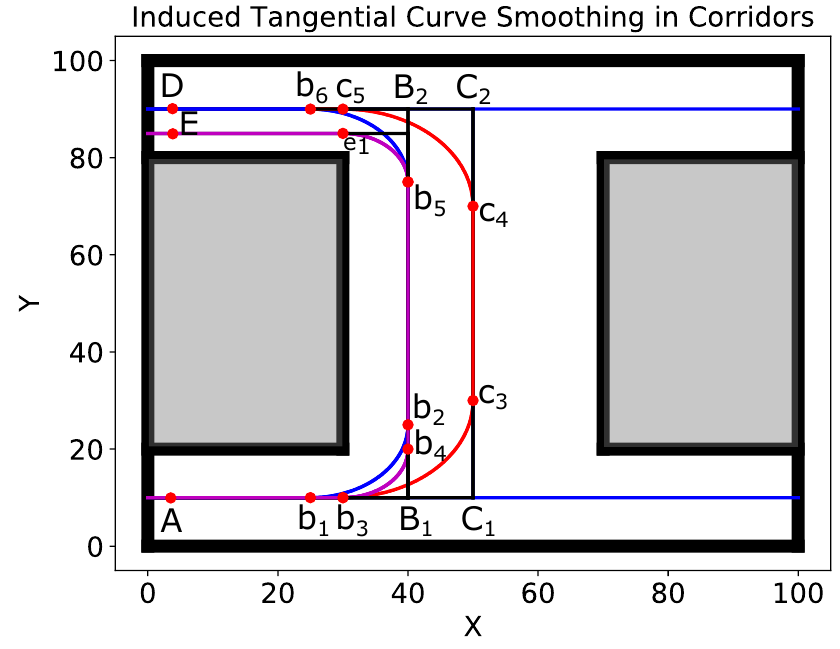
Figure 7. The case of path smoothing in corridors using